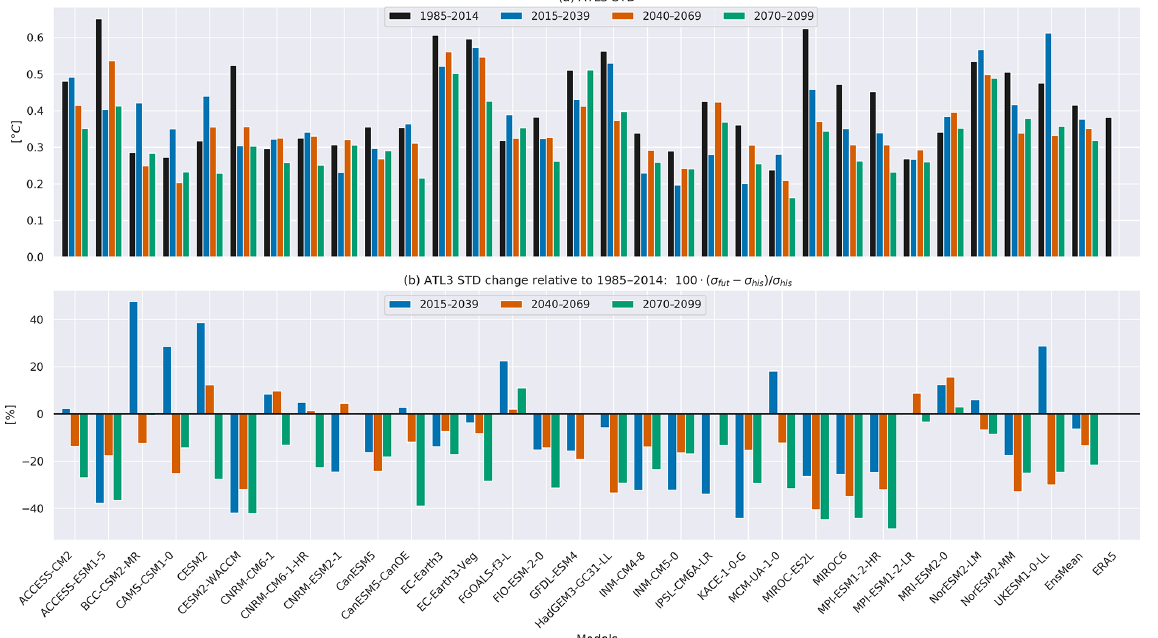
Figure 7. (a) Standard deviation of the JAS Atlantic Niño index over the 1985–2014, 2015–2039, 2040–2069 and 2070–2099 periods for the 30 GCMs. The result for ERA5 is also shown for the 1985–2014 period. (b) Near-term (2015–2039), mid-term (2040–2069) and long-term (2070–2099) changes of the JAS Atlantic Niño standard deviation relative to the present-day period (1985–2014) for each of the 30